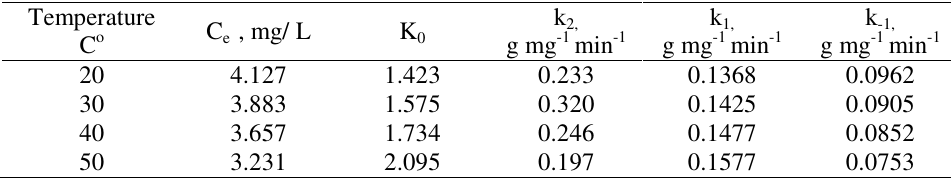
Table 5. Second order rate constants for the adsorption of chromium onto MPGP (k for forward (k ) and reverse (k ) process at different temperatures 1 -1